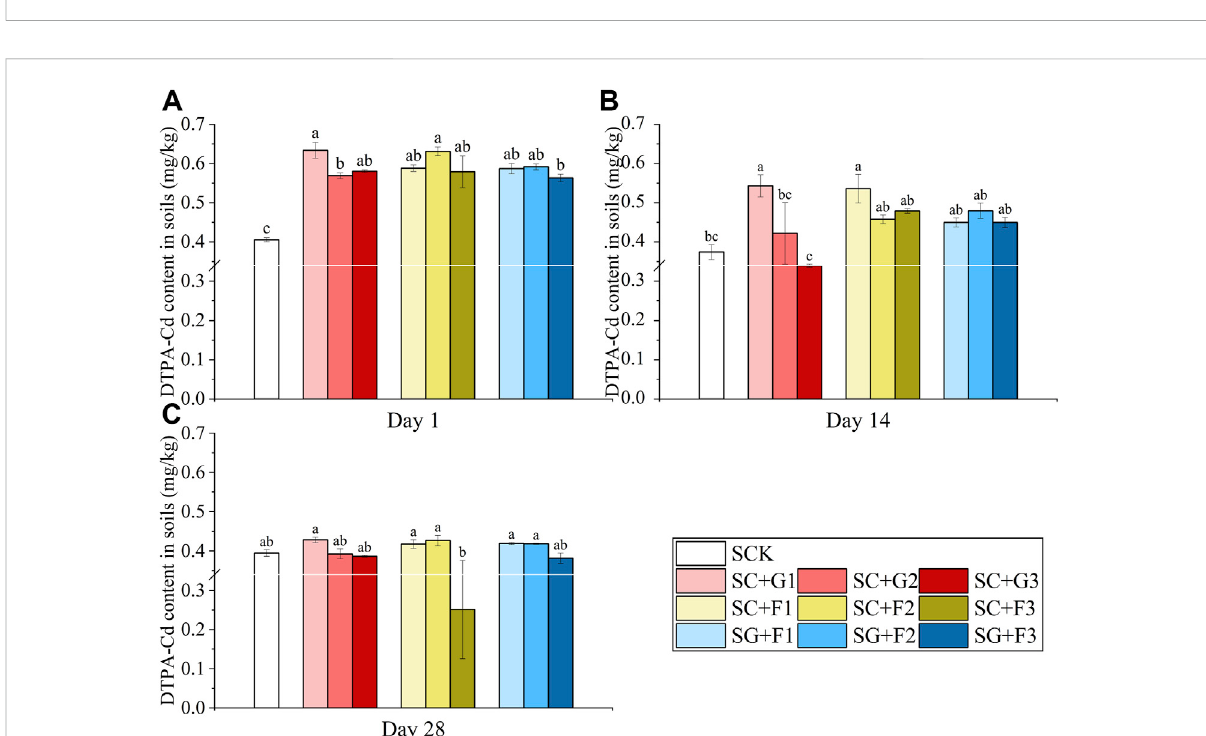
FIGURE 4 Changes in DTPA-Cd in soil under the combined treatment of citric acid, Gly and fructose on days 1 (A) , 14 (B) , and 28 (C) . The combination of citric acid + Gly: SC + G1, SC + G2, SC + G2; the combination of citric acid + fructose: SC + F1, SC + F2, SC + F3; the combination of Gly + fructose: SG + F1, SG + F2, SG + F3 (Different letters in each sampling timepoint show signi fi cant differences, p <